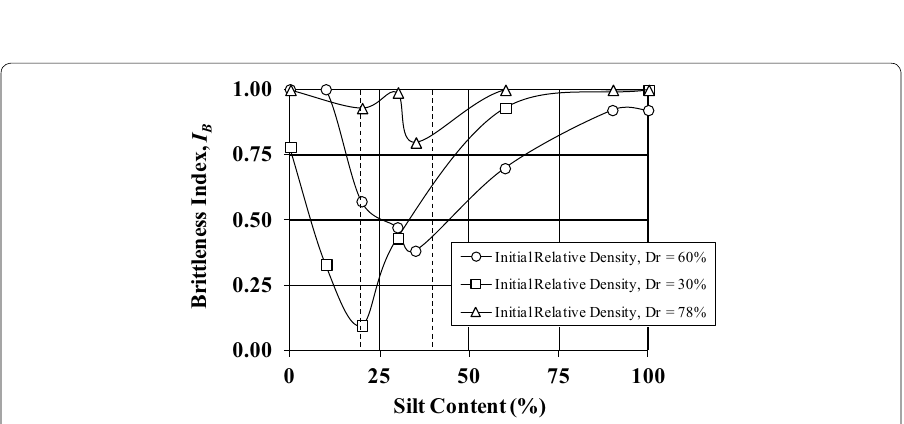
Fig. 23 Brittleness index of sand–silt mixtures at different initial relative densities